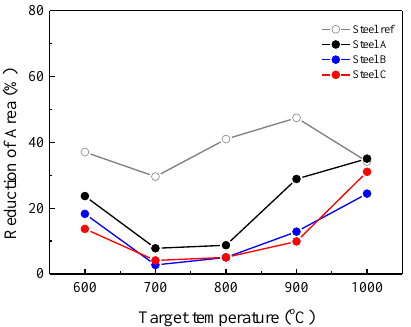
Figure 2. Hot ductility curve with various V and Mo composition.